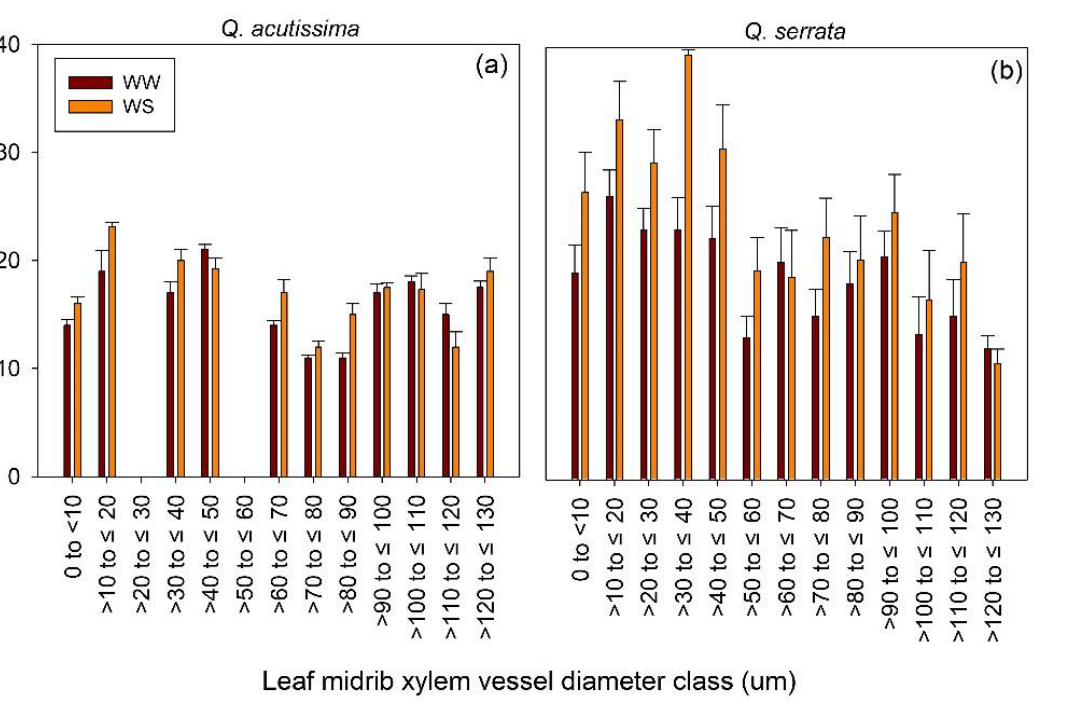
Figure 6. Frequency distribution of leaf midrib xylem vessel diameter classes of ( a ) Quercus acutissima and ( b ) Q. serrata in well-watered (WW) and water-deficit stress (WS) treatments after eight weeks. Vertical bars indicate the SE (n = 10). Still-green leaves were the ones harvested for leaf anatomical traits measurement.